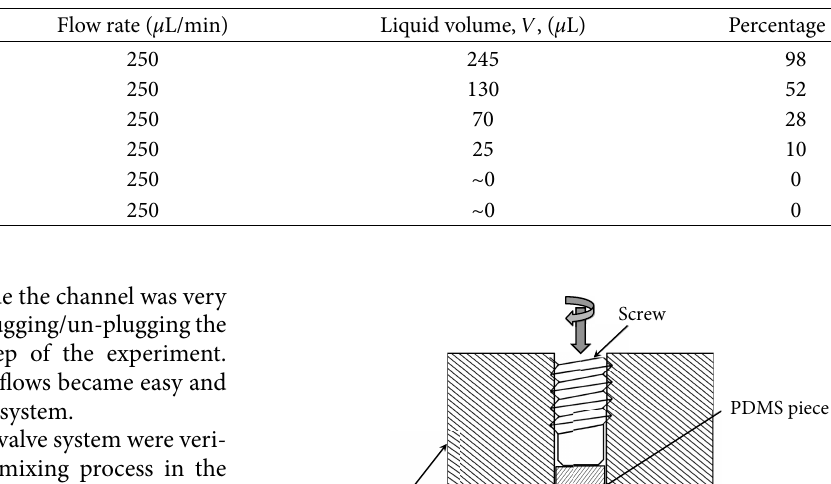
Table 2: Results of studying effect of screw operation on liquid volume at outlet of microfluidics.